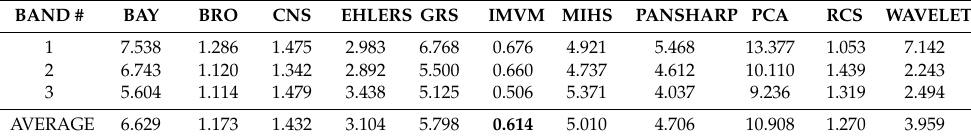
Table 7. Spectral consistency: di ff erence in variance (DIV).